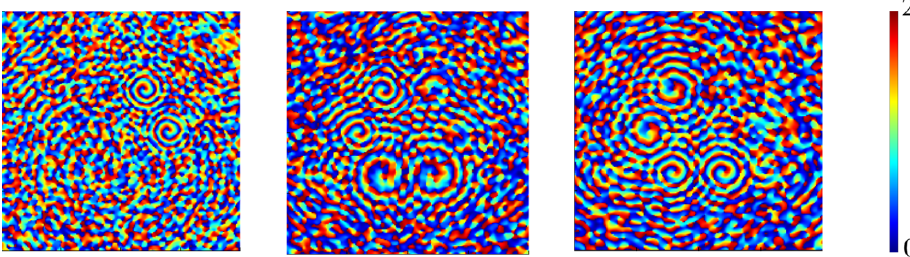
Figure 9. Phase profiles of the beam generated by B, G, and R wavelengths. From Figure 10, we can see that with the changes in the number and mode of light spots, the uneven energy distribution of light spots becomes increasingly obvious, and there are other diffraction spots. To solve this problem, we can balance the energy intensity between each light spot by changing Equation (7) and regulate the phase matching degree of each wavelength by changing the value in Equation (1), in order to weaken the intensity of the interference diffraction spot.